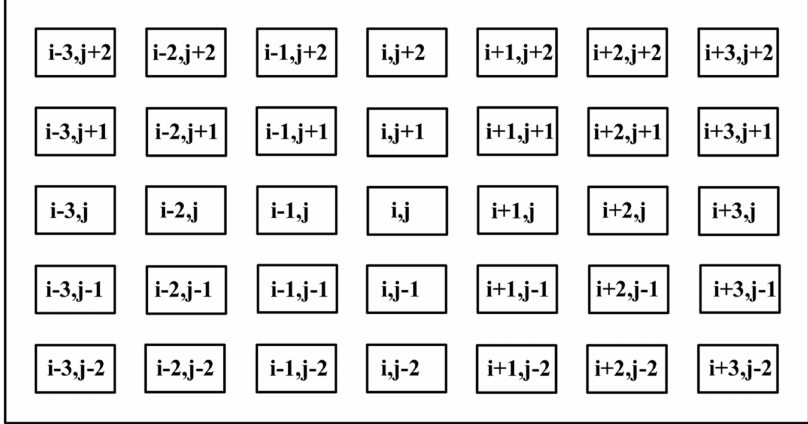
Figure 5. The diagram of the pillar